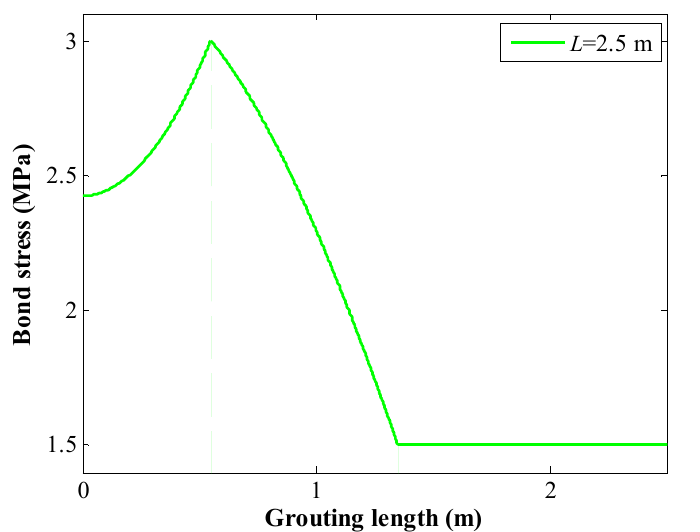
Figure 11. Bond stress distribution at the boundary surface at the peak force when the grouting length was 2 m.